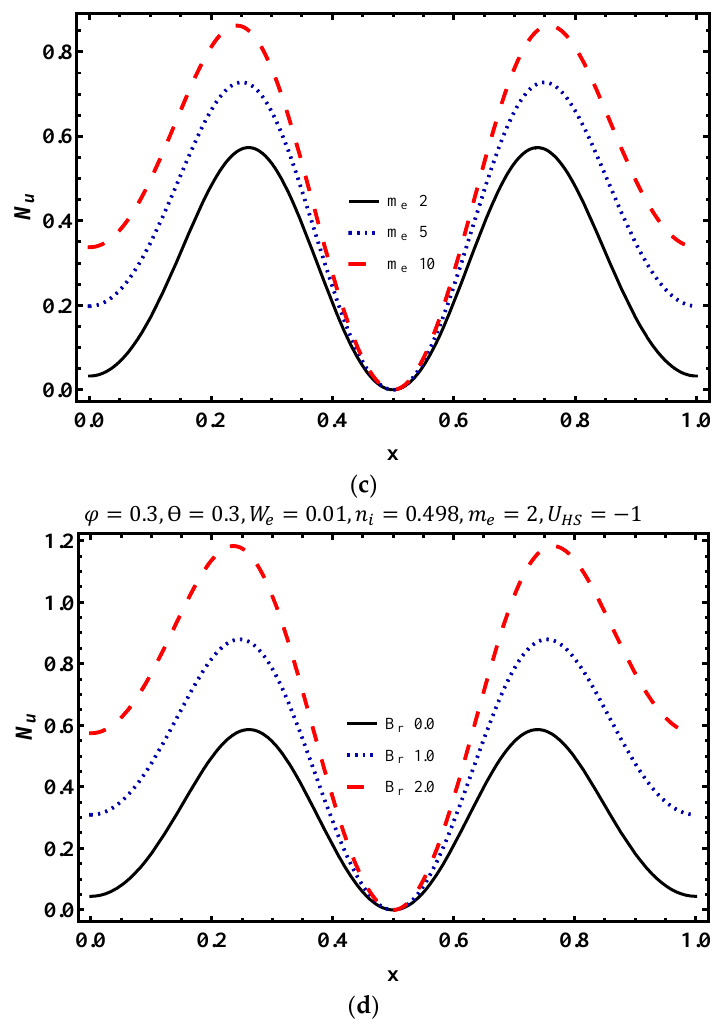
Figure 10. Nusselt number N u profile for ( a ) W e ; ( b ) n i ; ( c ) m e ; ( d ) B r